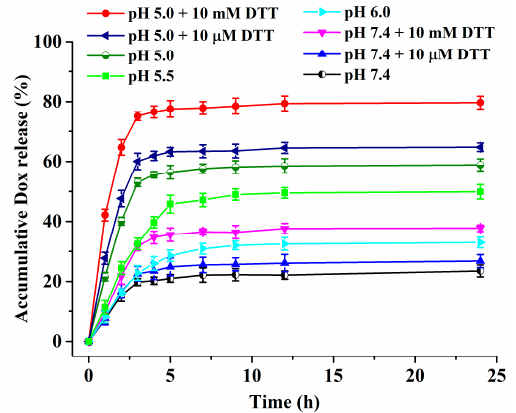
Figure 4. In vitro drug release profiles of Dox from RS@MS(Dox):dsPEI nanoparticles in PBS at dif- ferent pH with or without DTT, respectively, at 37